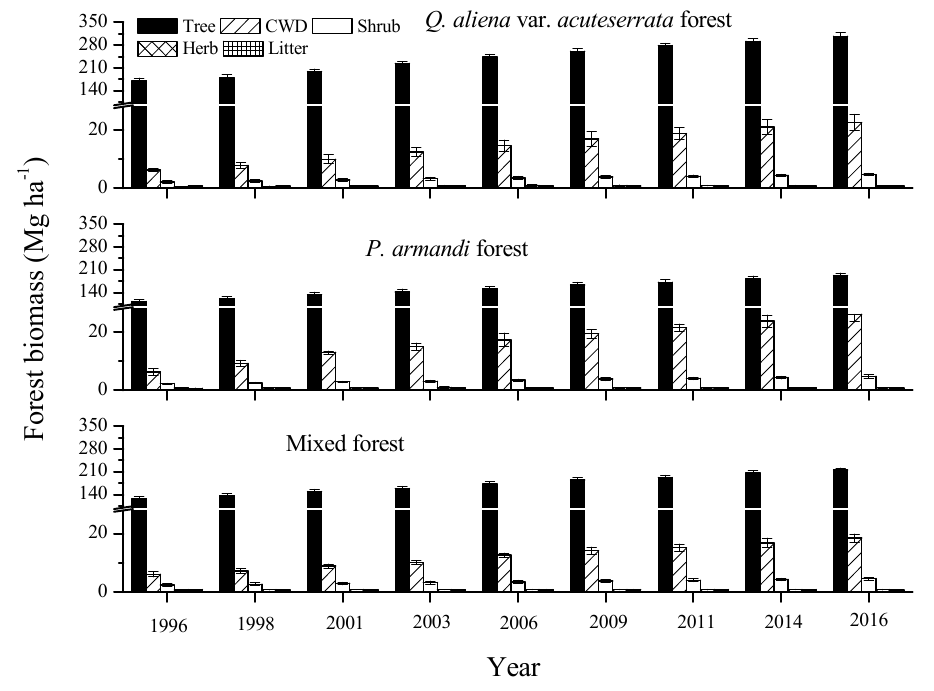
Figure 3. Forest biomass (the living trees, shrubs, herbs, litter and CWD) at the nine tree censuses during 1996–2016 for the three forest types in the Huoditang Experimental Forest Farm in the Qinling Mountains (China). The error bars represent the standard error of the mean, and are based on the plot as the experimental unit ( n = 6).